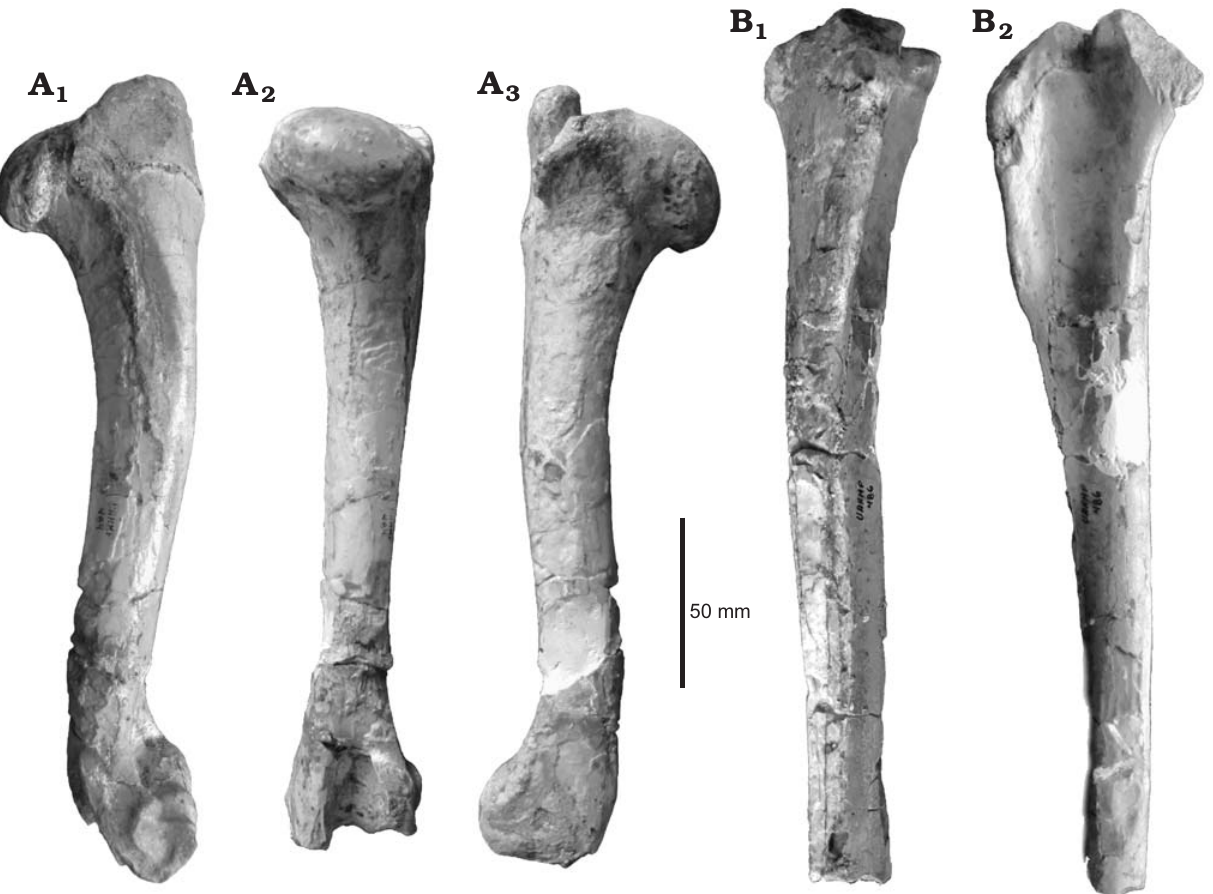
Fig. 5. Humerus and tibia of the cervid mammal Capreolus constantini Vislobokova, Dmitrieva, and Kalmykov, 1995 from the Pliocene of Hidalgo, Mexico. A . UAHMP 432, right humerus, in lateral (A